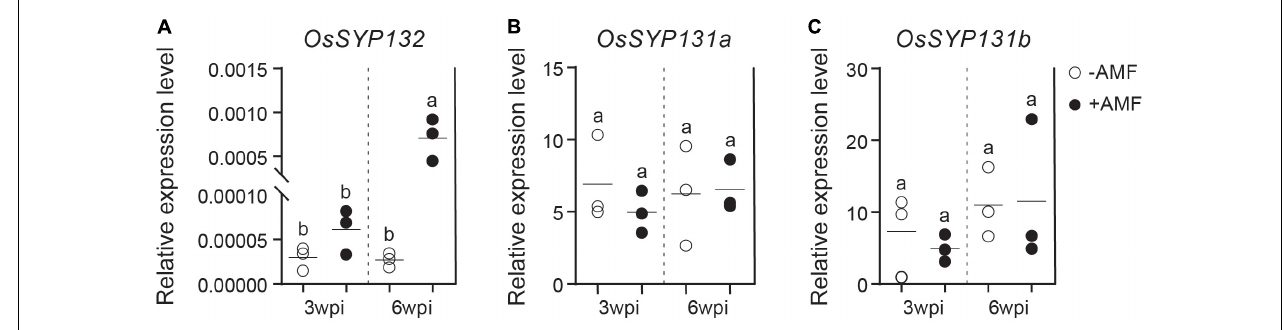
FIGURE 2 | The expression patterns of three OsSYP13 genes in rice roots during arbuscular mycorrhizal (AM) symbiosis (A–C) . The relative expression levels of OsSYP132 , OsSYP131a and OsSYP131b were measured by Quantitative RT-PCR (qRT-PCR). Rice wild-type (WT) roots were either mock inoculated (–AMF) or colonized by Rhizophagus irregularis (+ AMF) were harvested at 3- and 6-weeks post-inoculation (wpi). The gene expression values were normalized to the rice housekeeping gene, ubiquitin 1 ( OsUBI1 ). Data are individual values from three biological replicates and the horizontal line shows the mean value. Different letters indicate significant statistical differences between groups evaluated by the Tukey’s honest significance test (between the pairs, P < 0.05 or P > 0.05). This is a representative experiment that was repeated three times.